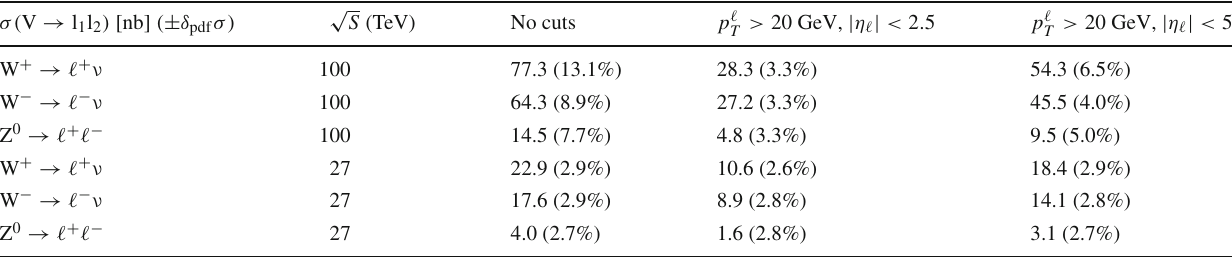
Table 3.2 W ± and Z 0 production cross-sections at NLO, including kinematic cuts and branching ratios (BRs) for one lepton family. The PDF uncertainties are from the NNPDF3.0 NNLO set